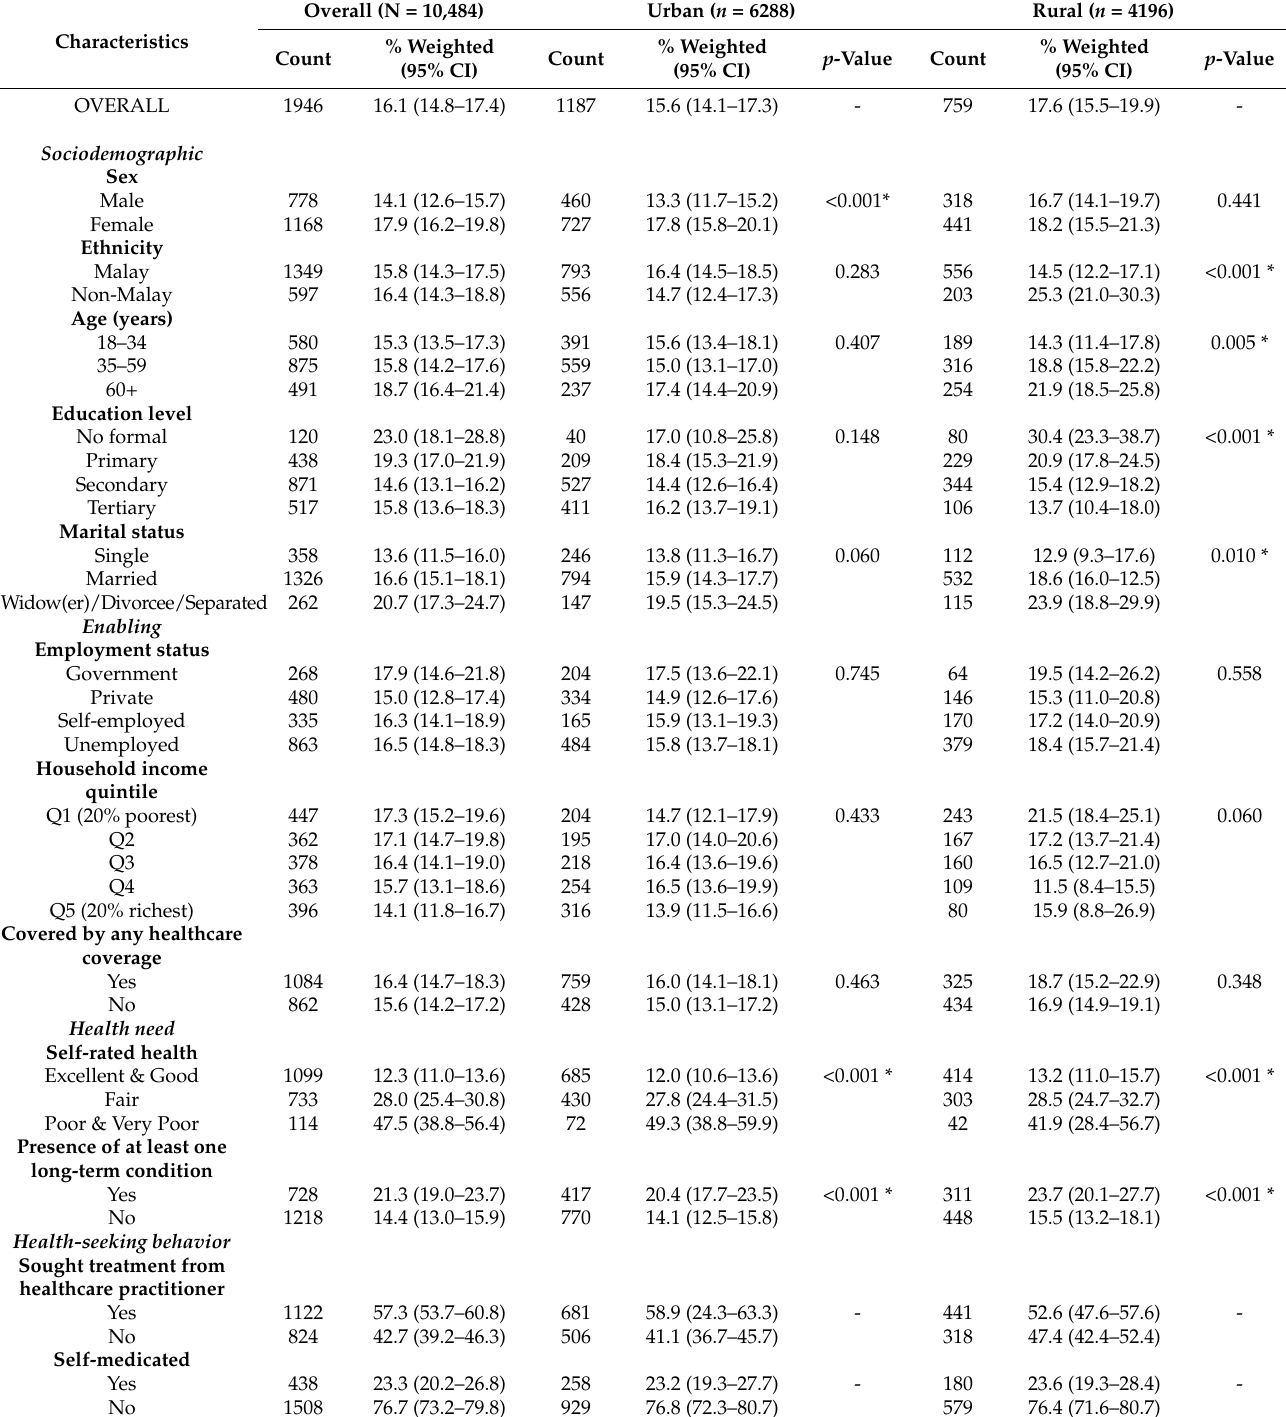
Table 2. Prevalence of those who reported sickness among Malaysian adults, stratified by urban- rural